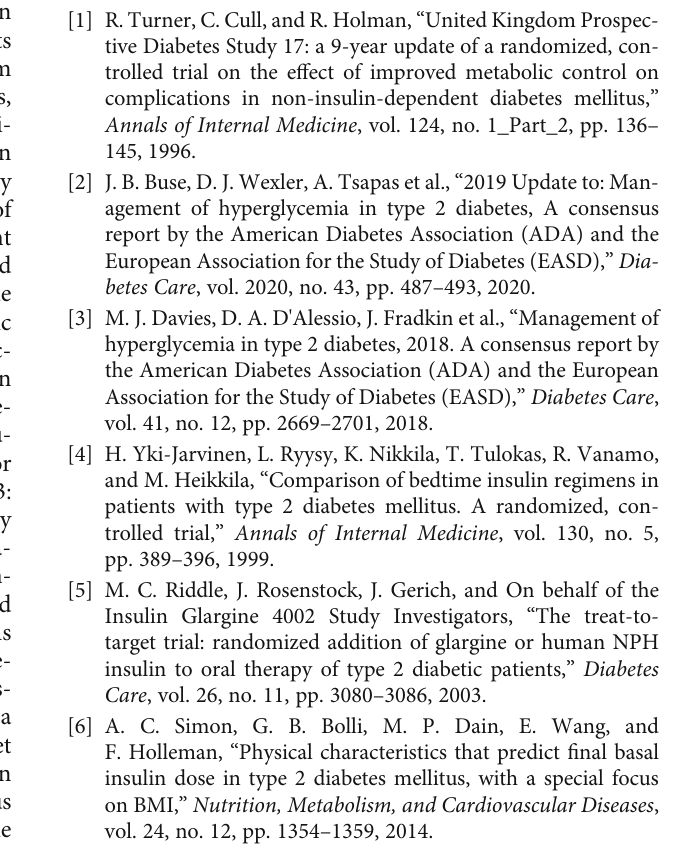
Supplementary Table S1: detailed presentation of search